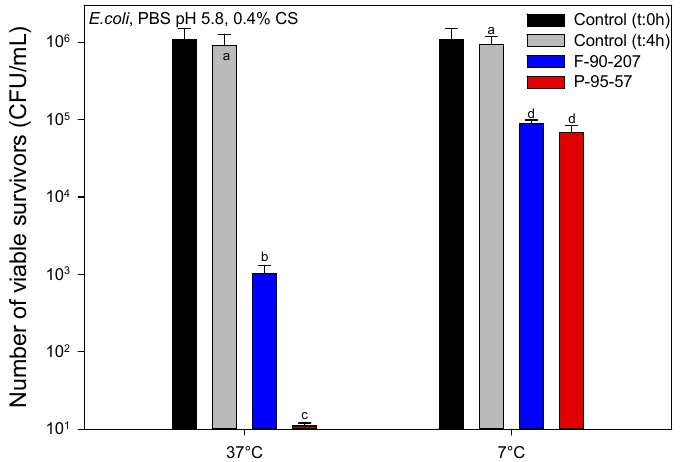
Figure 8. Effect of temperature on the antibacterial activity of chitosan (number of viable survivors). Bars with different letter are significantly different ( p < 0.05). Samples are F-90-207 (flakes) and P-95-57 (powder). The number of viable organisms was the same after 18 and 48 h incubation on the agar plates, suggesting that recovery from sub-lethal injury had not taken place. Means that do not share a letter are significantly different with a confidence level of 95% by Tukey pairwise comparisons.